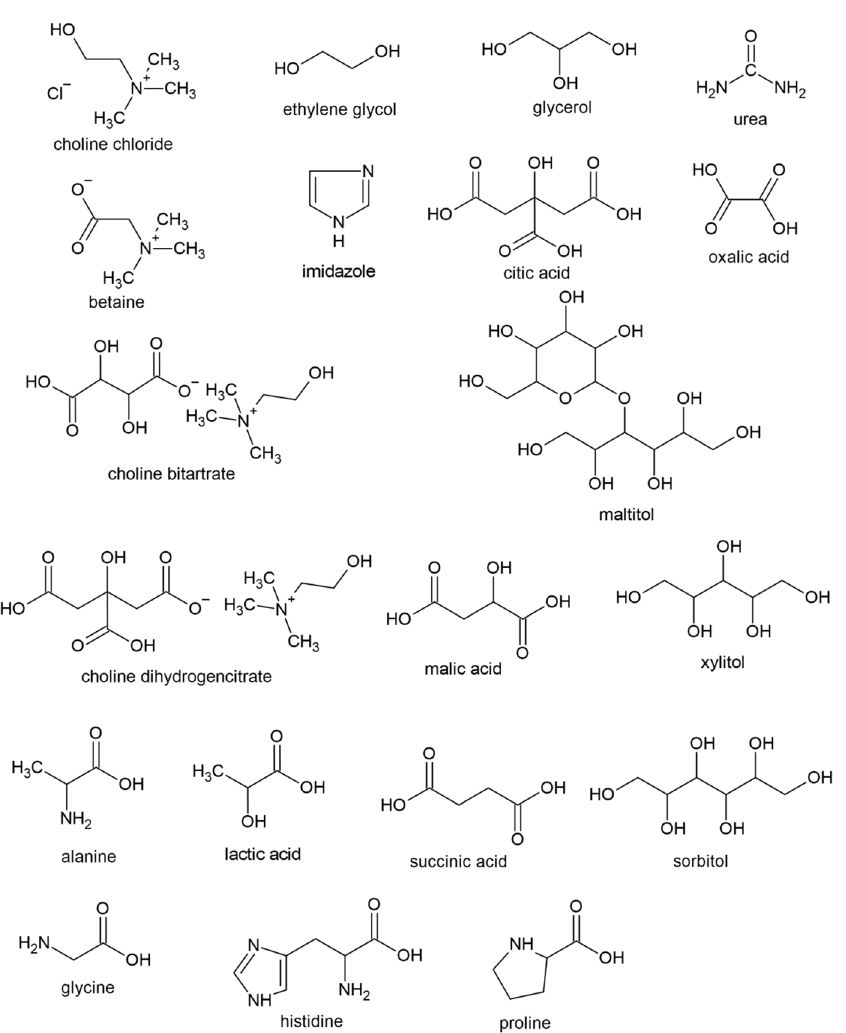
Figure 1. The most popular compounds of deep eutectic solvents used for starch treatment. Research on replacing the substances considered toxic or non-environmentally friendly with the DES systems is being performed. Reports on using DESs in metal processing, purification, gas adsorption, biomass treatment as well as the reaction media or modification agents can be found